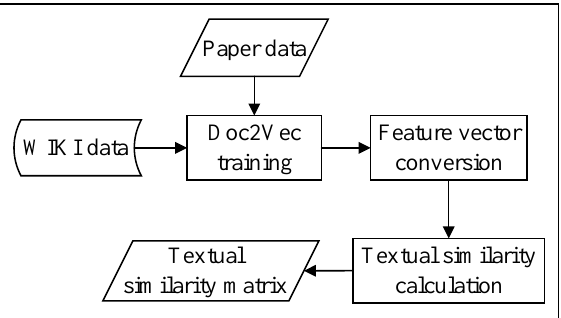
Figure 2. Textual similarity calculation